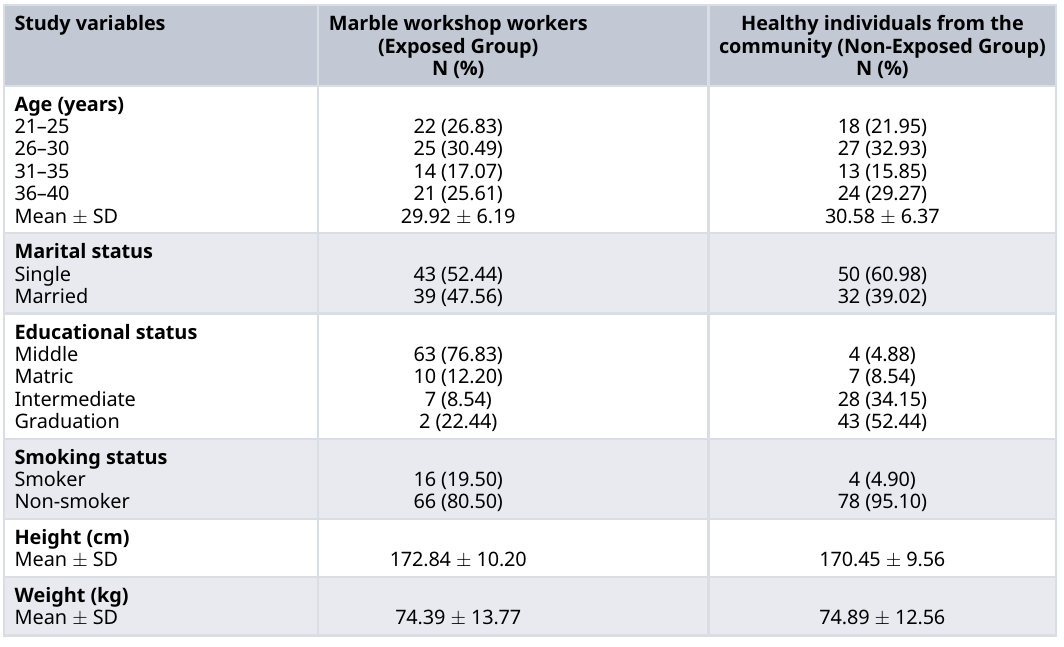
Table 1. Demographic characteristics of marble workshop workers (Exposed Group) and healthy individuals from the community (Non-Exposed